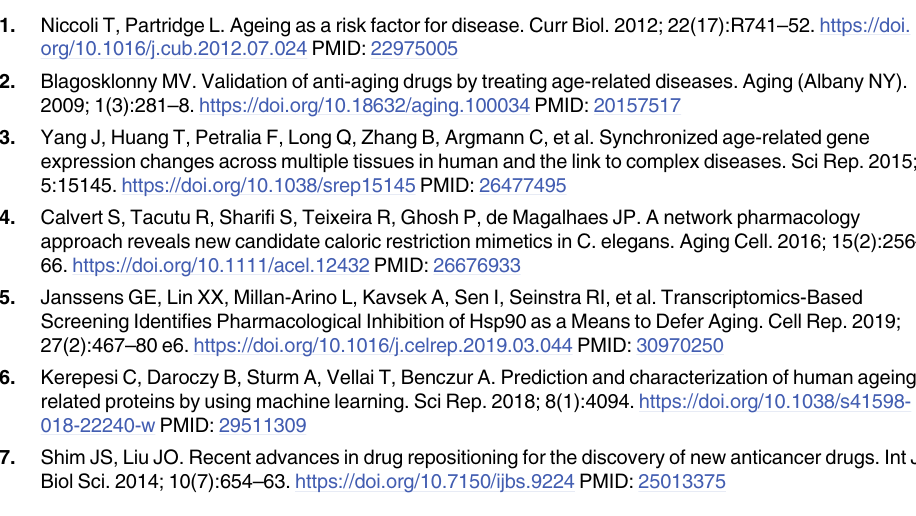
S6 Fig. Quantification of morphologic alterations treated with anisomycin or randomly combined drug pairs. Nuclear morphology changes in DAPI-stained HL-60 cells as shown above were counted and graphed. (A) anisomycin and combined drug pairs, (B) trichostatin A + chlorzoxazone, vorinostat + trichostatin A, anisomycin + glibenclamide, anisomycin + danazol. � p < .05, �� p < .01 vs H2O2 group. (PDF) S7 Fig. Measuring Senescence by beta-galactosidase staining after treatment with anisomy- cin or randomly combined drug pairs. HL-60 cells were treated as indicated in each picture Fluorescent microscopy images were obtained using a fluorescence microscope system, and then beta-galactosidase positive cells were indicated with red arrows. (PDF) S8 Fig. Percentage of beta-galactosidase positive cells by anisomycin or randomly com- bined drug pairs. HL-60 cells shown above were quantified and (A) anisomycin and combined drug pairs, (B) trichostatin A + chlorzoxazone, vorinostat + trichostatin A, anisomycin + glib- enclamide, anisomycin + danazol. � p < .05, �� p < .01 vs H2O2 group.